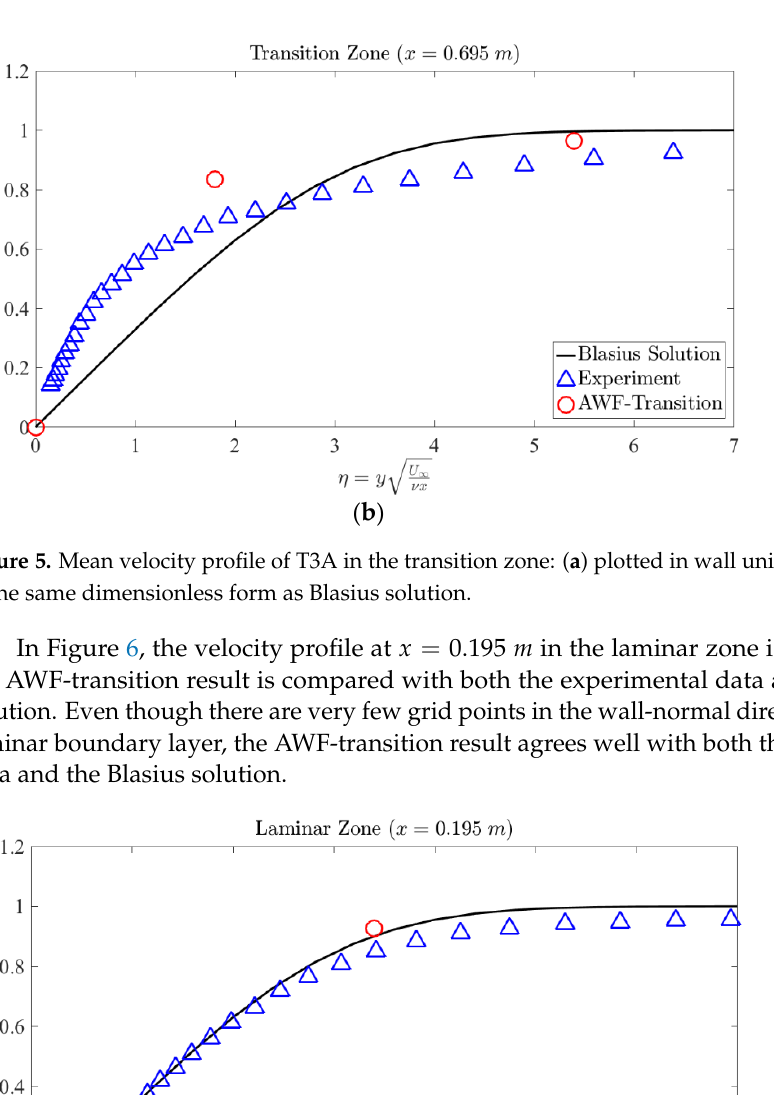
Figure 7. Mean velocity profile of T3A plotted in wall units in the fully turbulent zone. 5. Conclusions In this work, the capability of AWF was extended to the prediction of the bypass- transition effect on the mean flow. To capture the transition onset and the transition pro- cess, the presently modified versions of the algebraic 𝛾 transition model of Kubacki and Dick [43,44] and the 𝑘 − 𝜔 turbulence model of Wilcox [46] were integrated into the pro- posed AWF-transition of an in-house CFD code. For validation, the T3A test case of bypass transition was used. This AWF-transition showed the predictive capability of detecting the transition onset and the transition process in the distribution of 𝐶 𝑓 over a flat plate. Moreover, the mean velocity profiles were well predicted in laminar, transitional and fully turbulent regions.